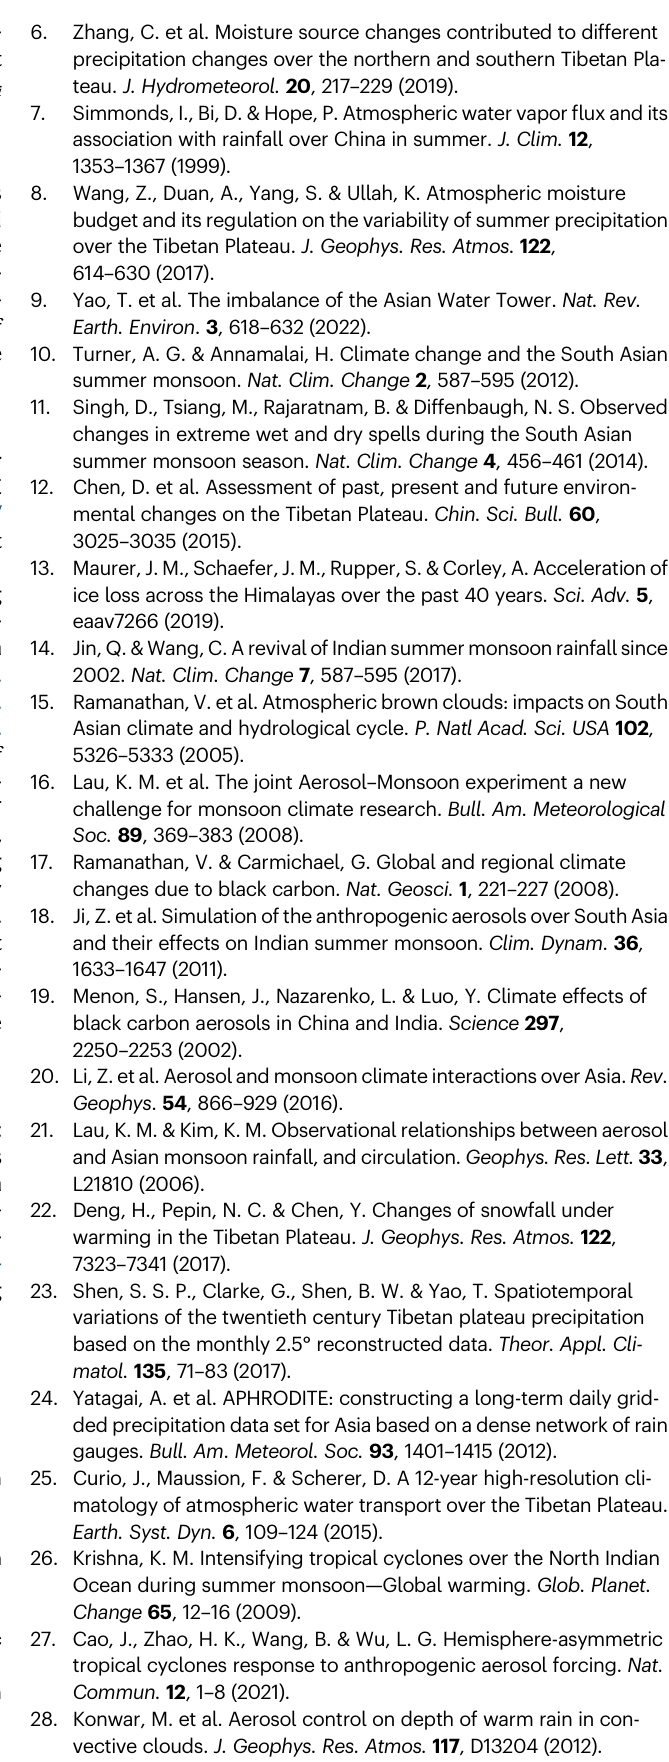
Fig. 1 and Fig. 14 are available at https://cds.climate.copernicus.eu/. GPCP data plotted in Supplementary Figs. 1 and 15 are available at https://psl.noaa.gov/data/. MERRA-2 reanalysis data used in Supple- mentary Section 1.3.3 and plotted in Supplementary Fig. 20 are